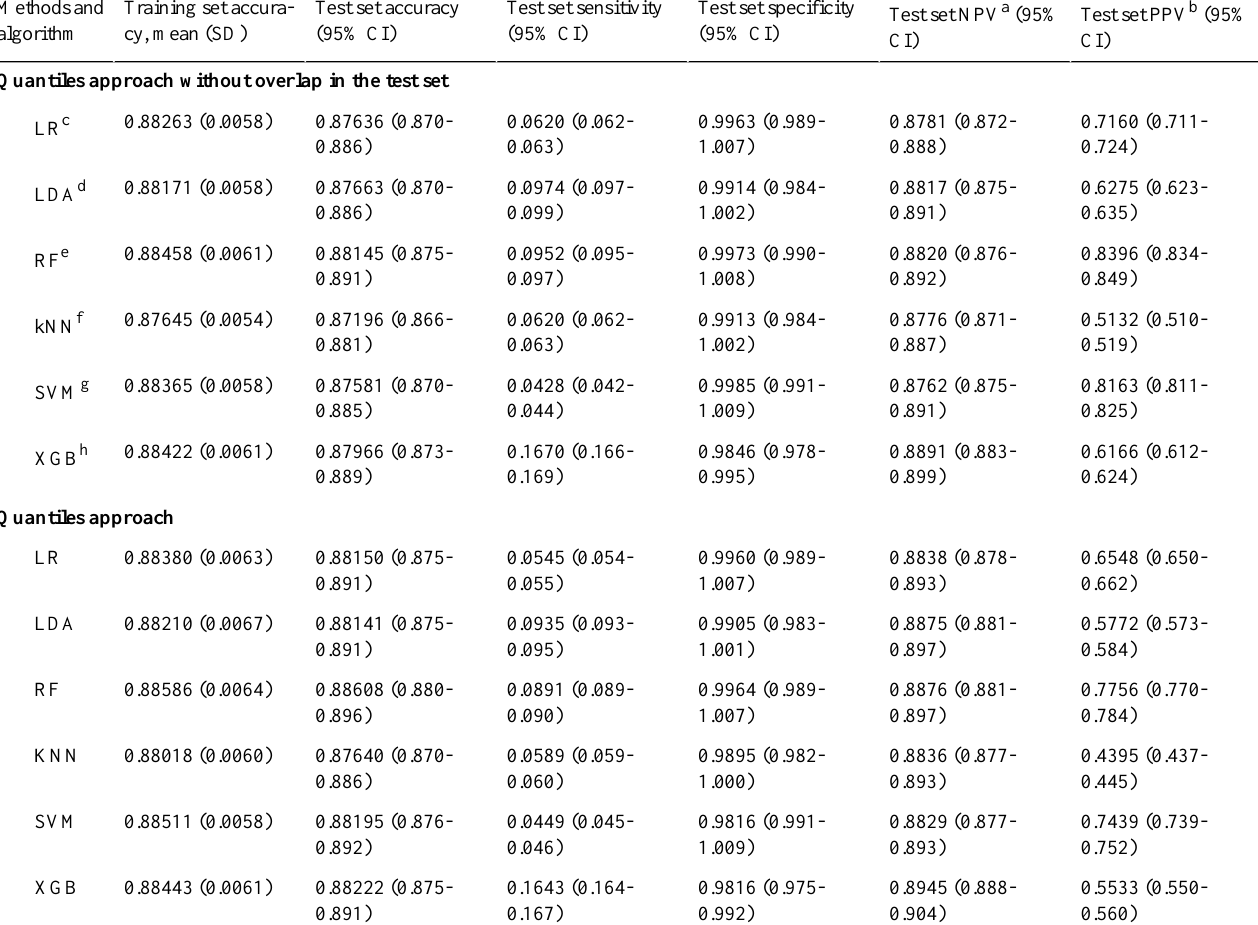
Table 13. Mortality model results for six algorithms using different performance metrics.